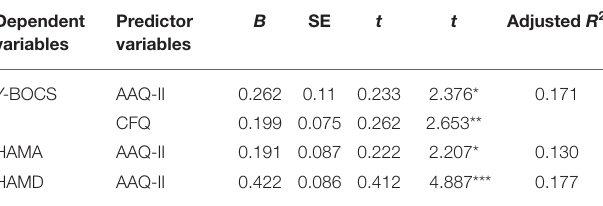
TABLE 4 | Results of regression analysis of obsessive–compulsive symptoms, anxiety, and depression. Dependent